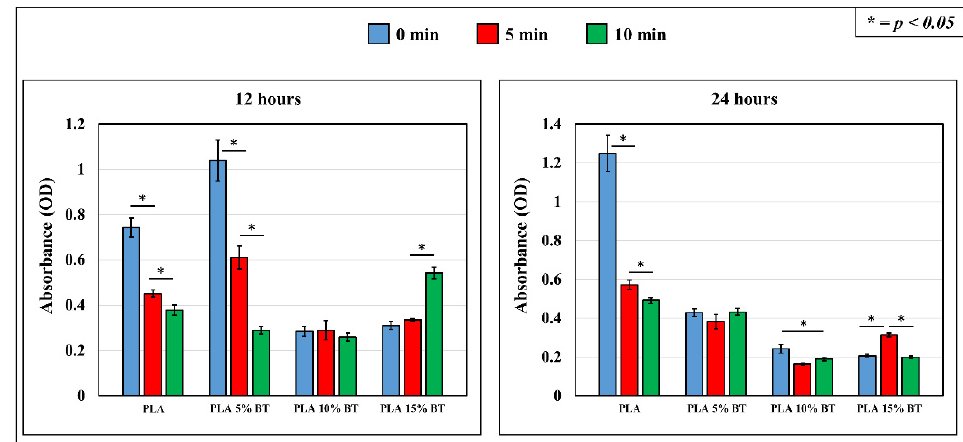
Figure 10. Experimental time-lapse results and statistical validation of optical density (O.D.) values related to the microbial viability test performed on the four samples after 12 and 24 h Staphylococcus epidermidis exposure.